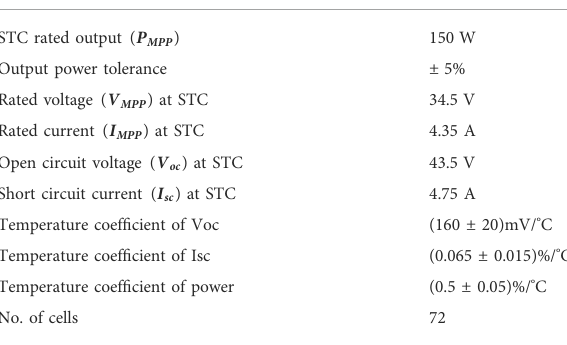
TABLE 1 Electrical speci fi cations of BP SX150S panel at STC.